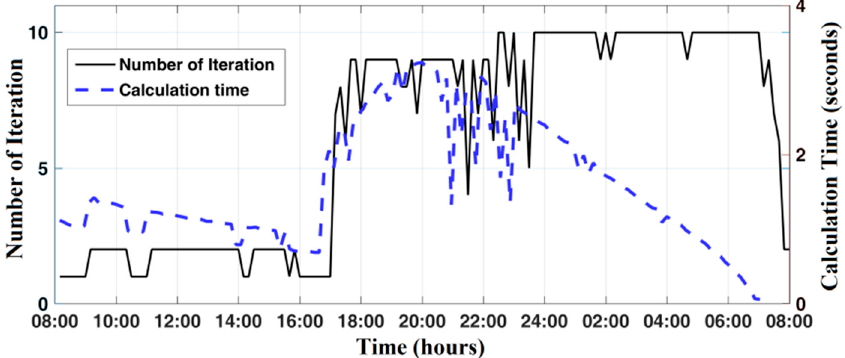
Figure 10. The number of iterations and the calculation time.